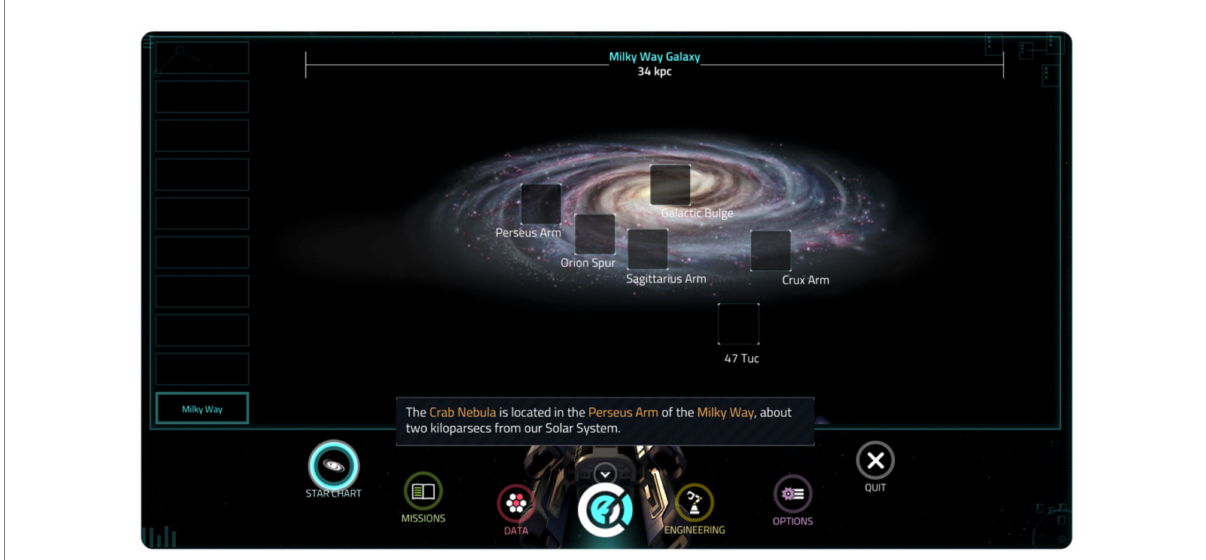
FIGURE 4 Interactive Star Chart. Students use the in-game Star Chart to navigate to various locations in the galaxy and access tools to observe and measure data from celestial objects. The game designers purposely created the star chart as “slices” of the galaxy to enable students to understand the scale of the universe while designing within the constraints of the gaming